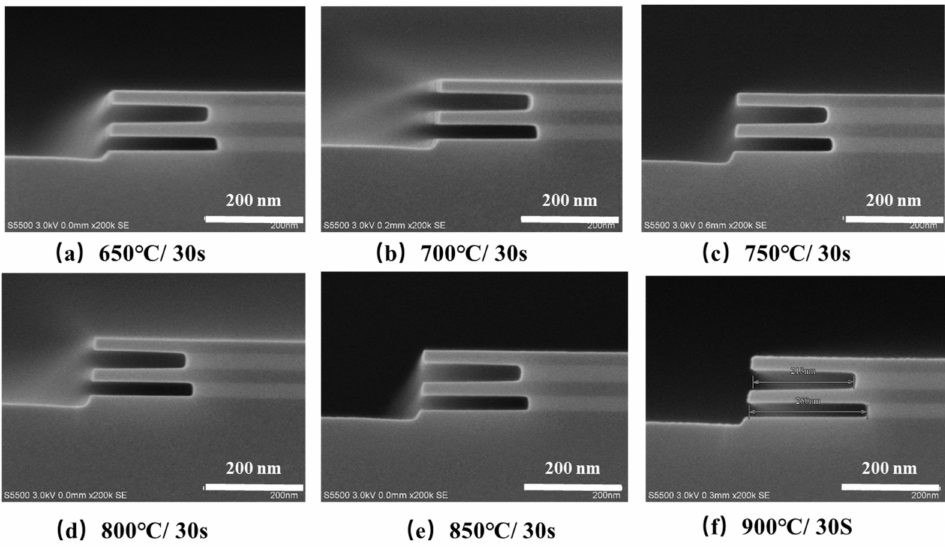
Figure 4. SEM images of the etched stacked GeSi/Si samples after rapid thermal annealing (RTA) at different temperatures: ( a ) 650 ◦ C/30 s, ( b ) 700 ◦ C/30 s, ( c ) 750 ◦ C/30 s, ( d ) 800 ◦ C/30 s, ( e ) 850 ◦ C/30 s, and ( f ) 900 ◦ C/30 s.